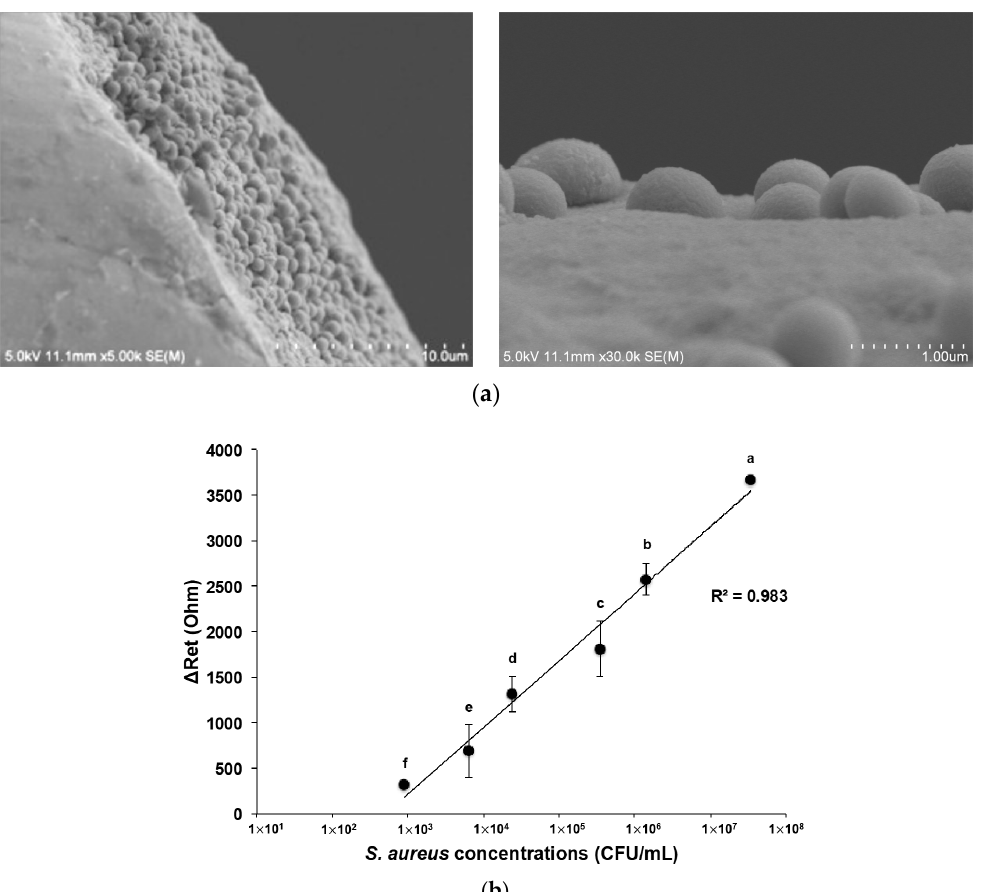
Figure 9. ( a ) SEM images of S. aureus bacteria cells on the base plane (left, ×5.0k) and the cylinder side (right, ×30.0k) of the microwire. ( b ) Changes in electron transfer resistance with S. aureus captured on the electrode surface of the S. aureus MEI sensor in pure solution. Error bars indicate the standard deviation of the mean. Different letters (a–f) in the figure indicate significant differences ( p ≤ 0.05).